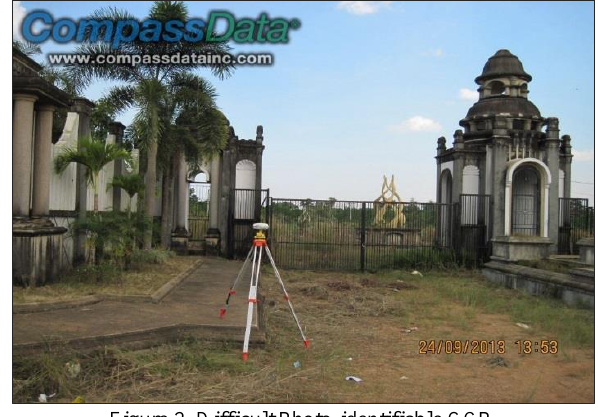
Figure 2. Difficult Photo-identifiable